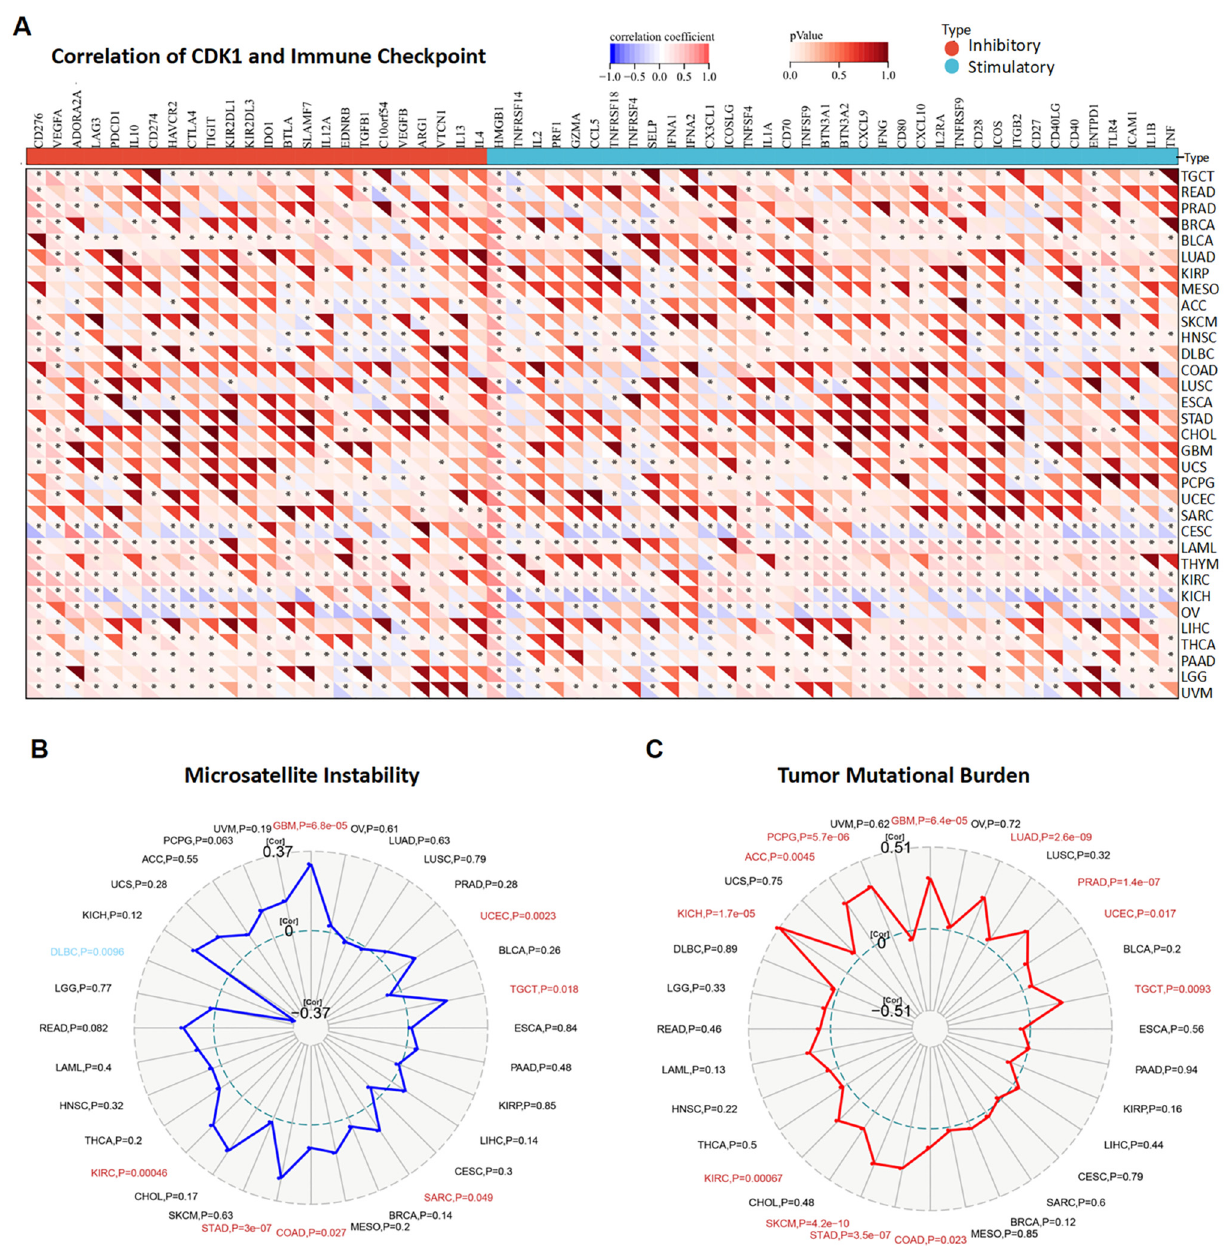
Figure 11. Correlations of immune checkpoints, MSI, and TMB with CDK1 expression. ( A ) CDK1 expression was significantly associated with many immune checkpoint genes in multiple tumors.